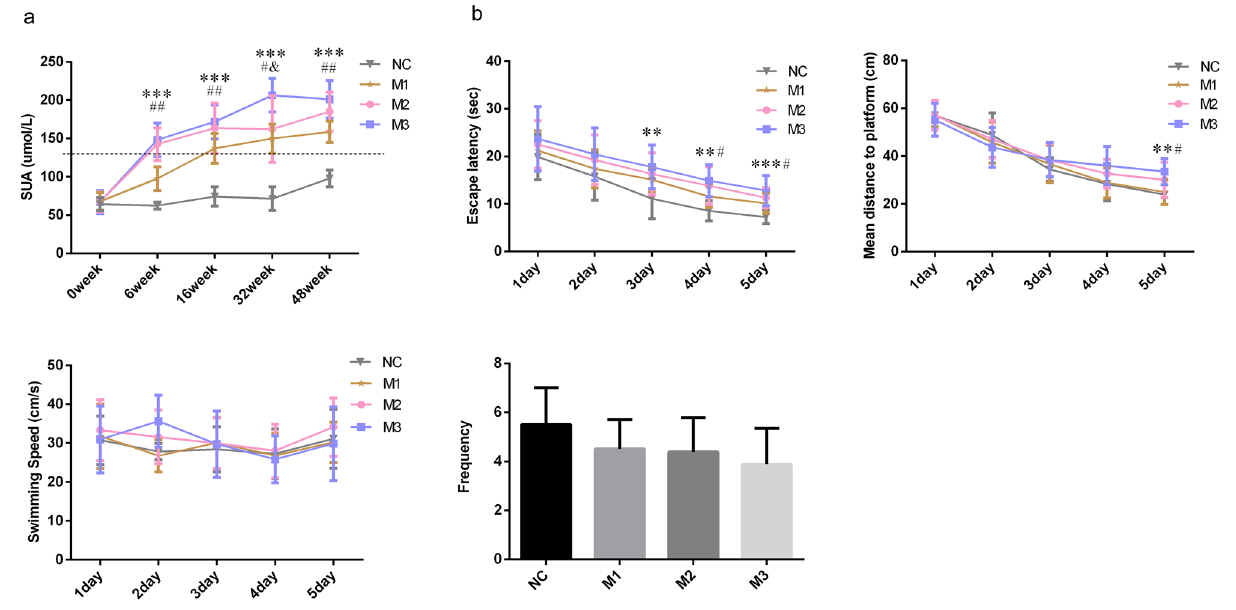
Figure 1. SUA levels and MWM indicators of rats. Data presented as mean ± standard deviation, n = 8 for each group. *P < 0.05 compared to the NC group, # P < 0.05 compared to the M1 group, and & P < 0.05 compared to the M2